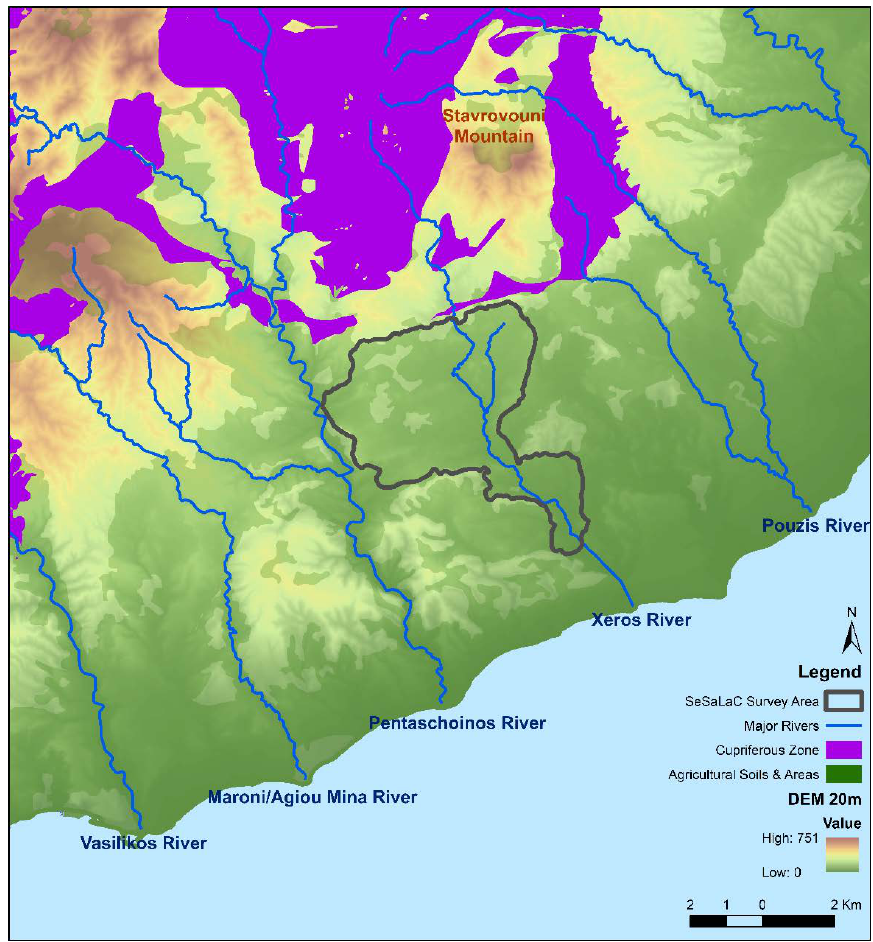
Figure 3. Regional map with the SeSaLaC survey area, major rivers, cupriferous zone, and agricultural soils and areas. Digital data courtesy of the Geological Survey Department, Republic of Cyprus (Map by Charalambos Paraskeva).